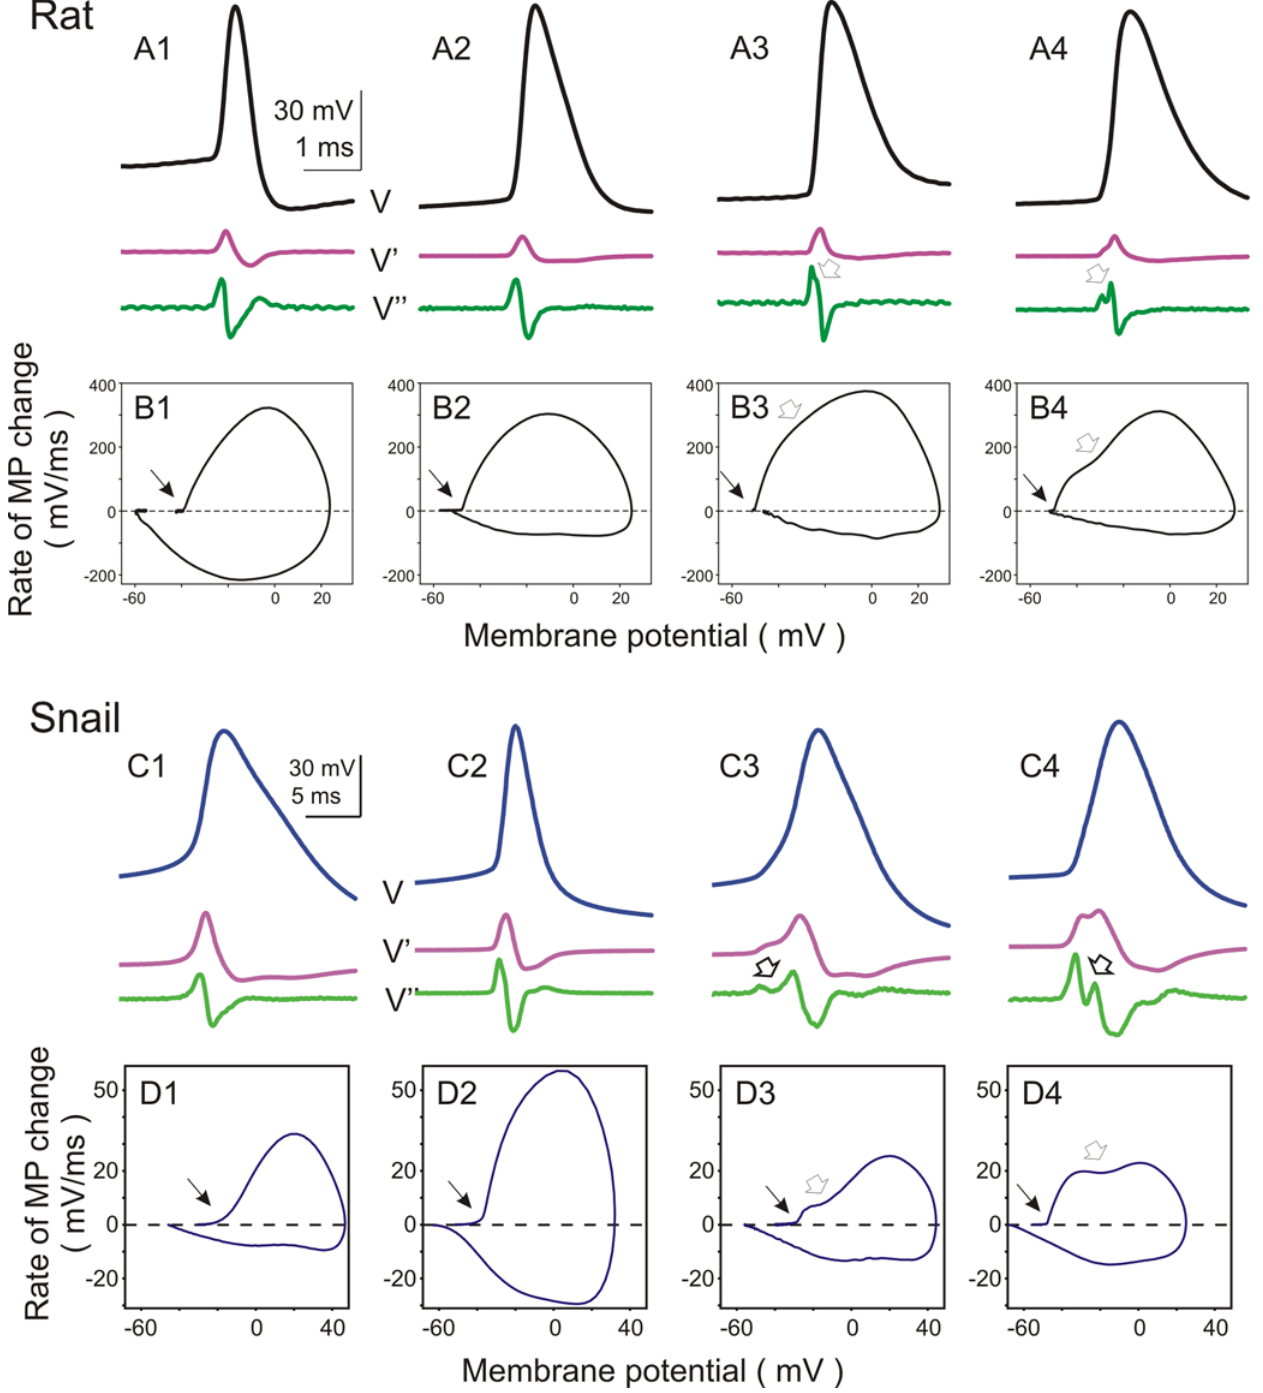
Figure 3. Action potentials in either rat and snail neurons have different waveforms. A, B: Action potentials recorded in 4 different neurons from rat neocortex. In A, voltage traces (V) are shown together with their first (V’) and second (V’’) derivatives. In B, phase plots of action potentials from A are shown. Ratio of errors of exponential fit over the piecewise-linear fit for these neurons were: 7.27; 6.07; 6.95; 3.46. C, D: Action potentials recorded in 4 identified snail neurons and their phase plots. Recordings from visceral ganglion neuron Visc5 (C1,D1); Left pedal ganglion neuron LPd2 (C2,D2); Right cerebral serotonergic neuron RC5HT (C3,D3) and Left pedal ganglion neuron LPd7 (C4,D4). Notice 8-fold difference in the Y-scale between B and D. In A–D open arrows indicate double-peak on the second derivative trace and bimodal shape of the phase plots. For both rat and snail neurons, the APs are sorted from left to the right by the increasing strength of manifestation of the double-peak on the second derivative trace and bimodal shape of the phase plots (open arrows). Ratio of errors of exponential fit over the piecewise-linear fit for 1–4 were: 0.79; 0.70; 0.92; 3.14. Notice that all APs in rat neocortex neurons have a sharp onset, irrespective of the presence and expression of the double peak in the phase plots.